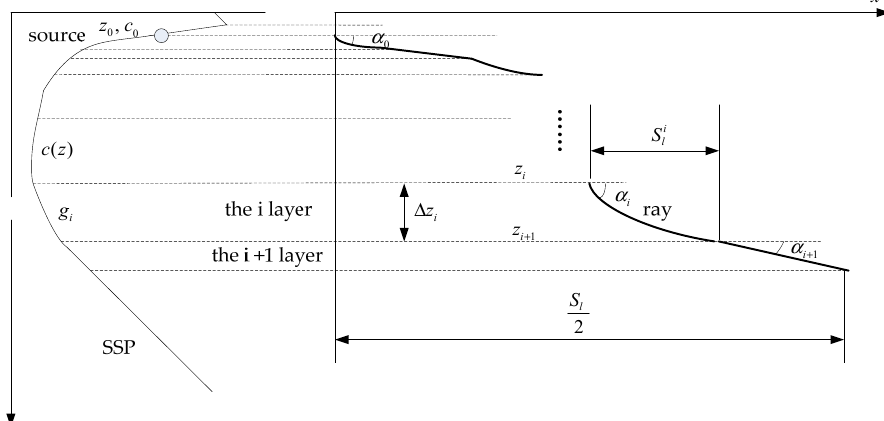
Figure 8. Linearized sound speed profile and the sound rays.